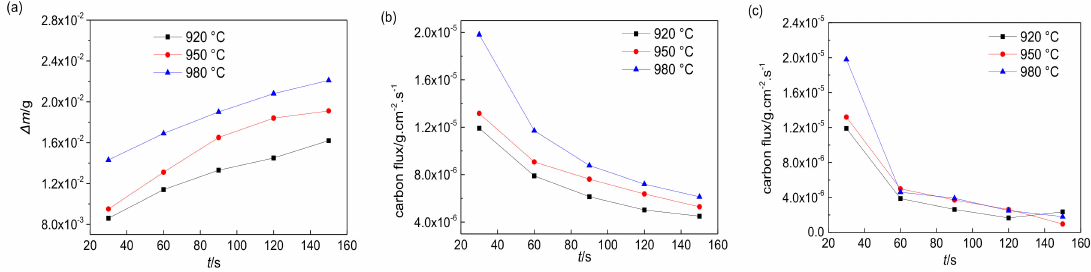
Figure 12. E ff ect of carburizing temperature on ( a ) mass increment, ( b ) average carbon flux, and ( c ) segmented average carbon flux of 18Cr2Ni4WA steel under 300